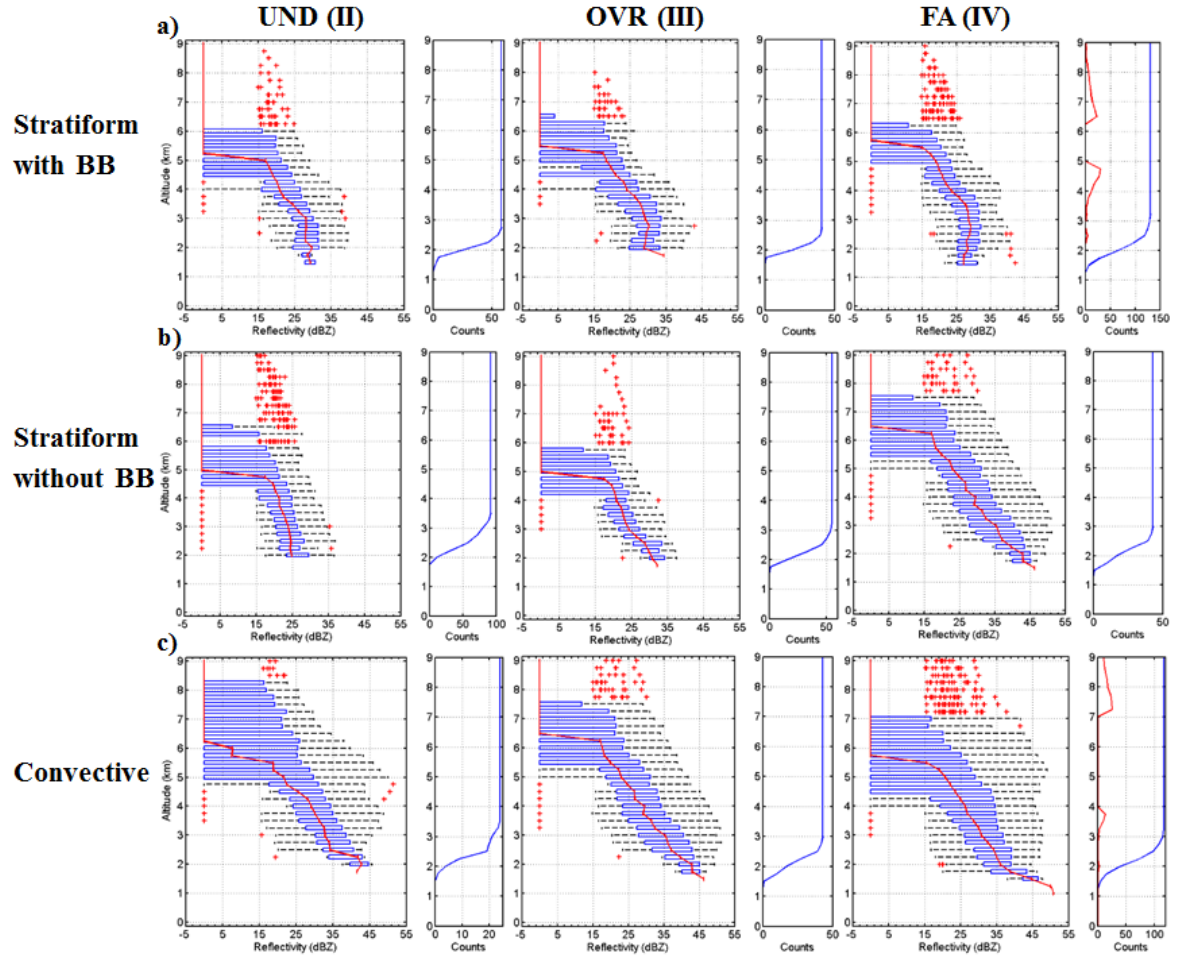
Figure 8. TRMM 2A25 reflectivity profiles for error classes II (UND), III (OVR), and IV (FA): (a) stratiform conditions with BB detected (rain type: 100 and 130, Fig. 6), (b) stratiform conditions without BB detected (rain type: 120 and 140, Fig. 6), and (c) convective conditions (rain type: 200, 210, and 237, Fig. 6). The blue box denotes the interquartile range (IQR) from the lower quartile (25th) to the upper quartile (75th); the median is indicated by the red mark inside the box. The red line connects the median reflectivity at all levels to yield the median reflectivity profile. The two horizontal lines (“whiskers”) extending from the central box represent the ± 1.5 IQR interval. Outliers (points falling out of ± 1.5 IQR) are marked as red crosses. For each error class, the right panel shows the number of observations with height; the red line for error class IV (FA) shows the distribution of outliers with